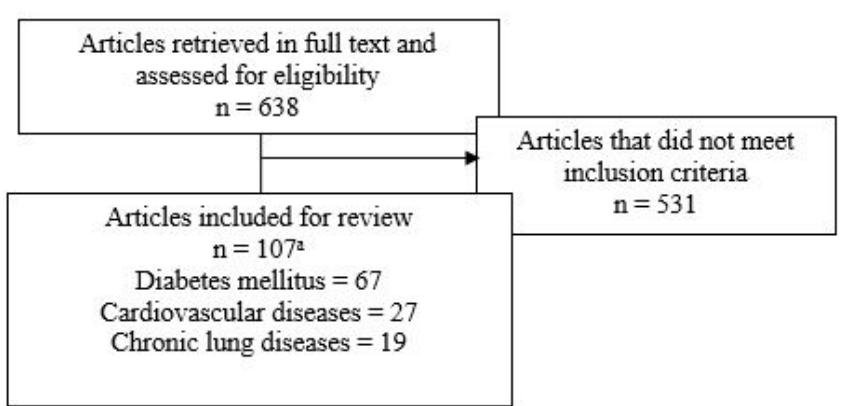
Figure 1. Study selection process.